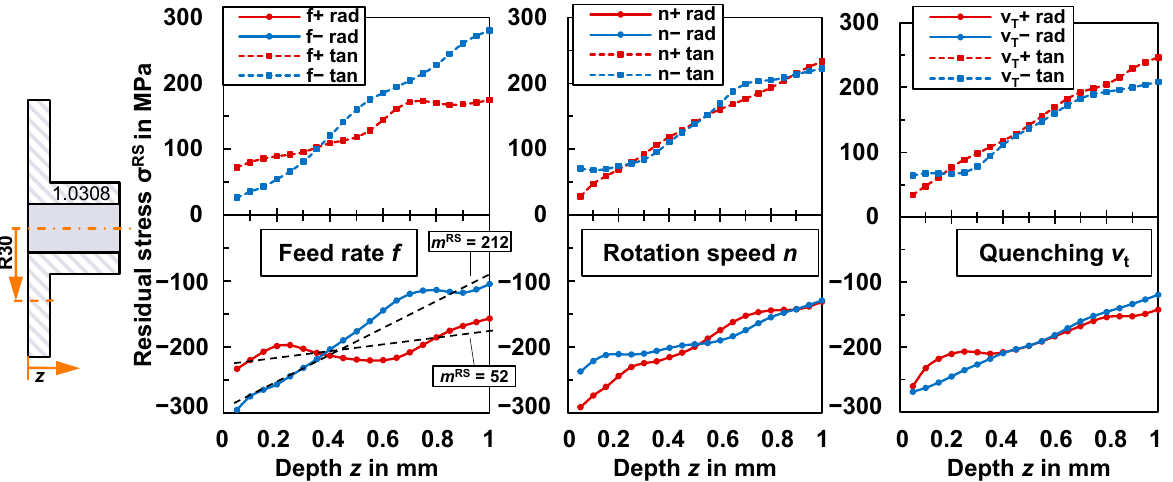
Figure 7. Residual stress depth profile in flanges formed by the friction spinning of steel tubes (1.0308) in the tangential and radial direction. Effects of the process parameters determined with the design of experiments methods (DoE): feed rate f , rotation speed n and quenching v t, performed with water after the process at T max = 400 ◦